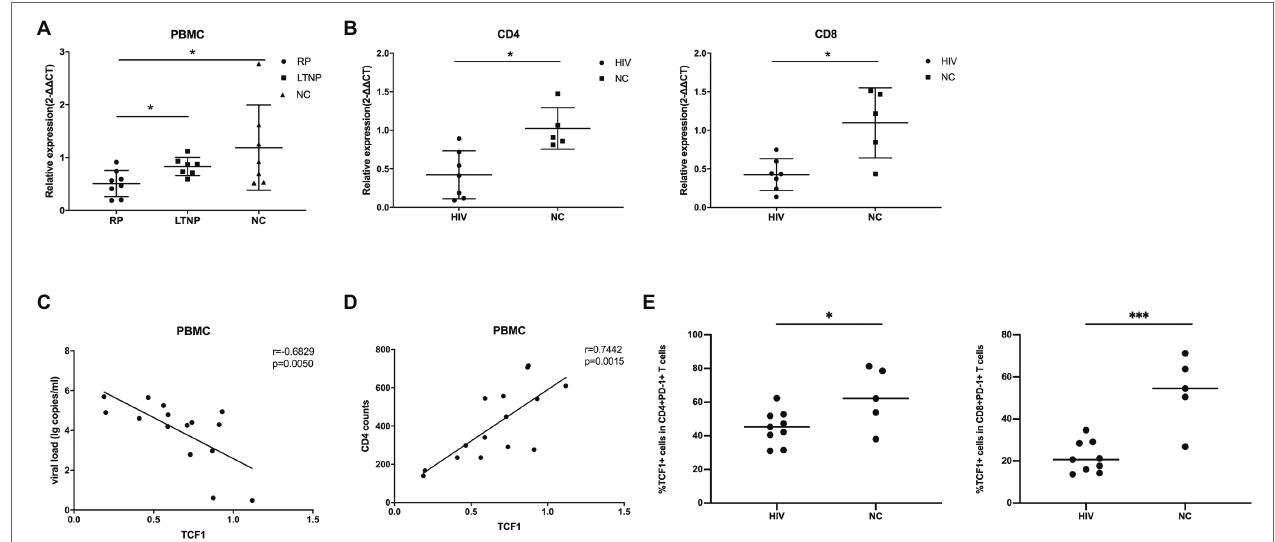
FIGURE 1 | TCF7 mRNA expression is reduced in HIV-infected individuals and is associated with disease progression. (A) TCF7 mRNA expression in peripheral blood mononuclear cells (PBMCs; from eight “rapid progressors” [RPs], seven long-term non-progressors [LTNPs], and seven HIV-negative control individuals [NCs]) was quantified and normalized to that of glyceraldehyde 3-phosphate dehydrogenase (GAPDH) transcripts, and expressed using the relative quantification method (2 - ∆∆ Ct ). TCF7 mRNA expression levels were compared between three groups by one-way ANOVA analysis. (B) TCF7 mRNA expression in CD4 and CD8 + T cells from HIV-infected individuals ( n = 7) and NCs ( n = 5) was quantified and normalized to that of GAPDH transcripts and expressed using the relative quantification method (2 - ∆∆ Ct ). The Mann–Whitney U test was used for intergroup comparisons. (C) Pearson’s correlation analysis of TCF7 mRNA expression and viral load in PBMCs from RPs and LTNPs ( n = 15). (D) Pearson’s correlation analysis of TCF7 mRNA expression and CD4 + T cell counts in PBMCs from RPs and LTNPs ( n = 15). (E) The percentage of TCF1 + cells in CD4 + PD1 + T cells and CD8 + PD1 + T cells form HIV-infected individuals ( n = 9) compared with HIV negative control individuals ( n = 5). * p < 0.05, *** p <